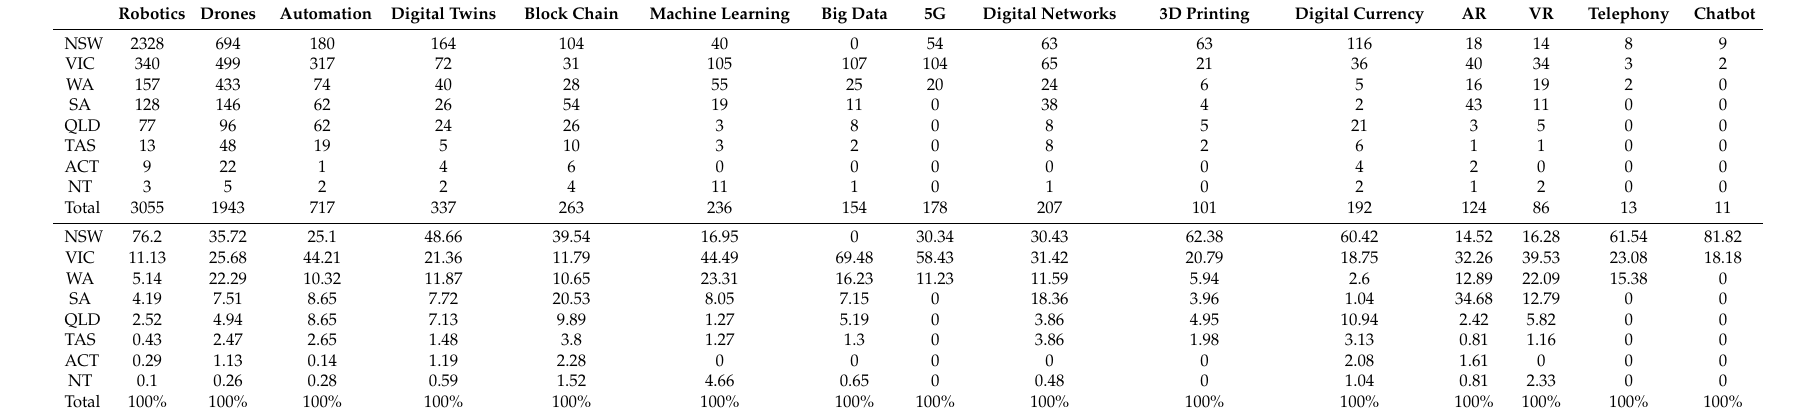
Table 3. Distribution of tweets by AI-related technologies per state /